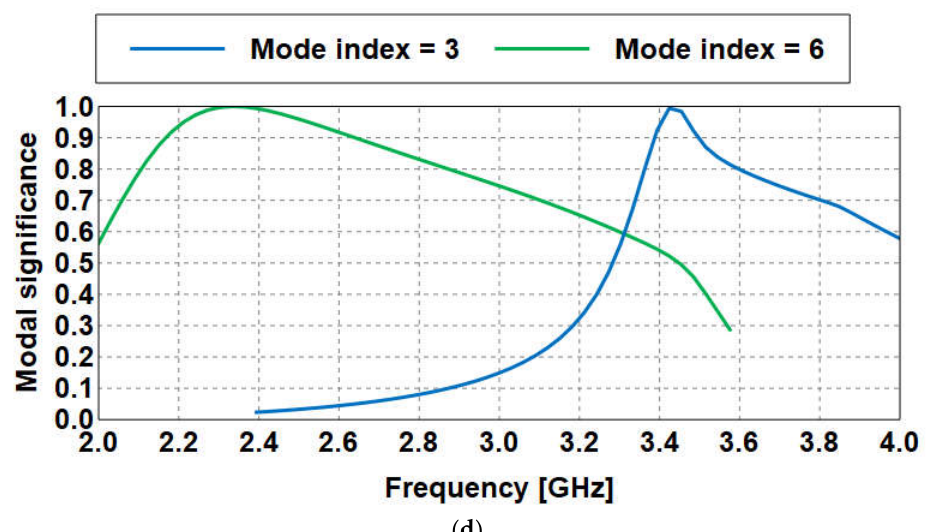
Figure 20. Modal significance for each step of the dual band antenna design ( a ) step 1 ( b ) step 2 ( c ) step 3 and ( d ) step 4. Table 10. Resonant Frequencies of modes for Each Design Step of The Dual Band Antenna Design Using CMA.